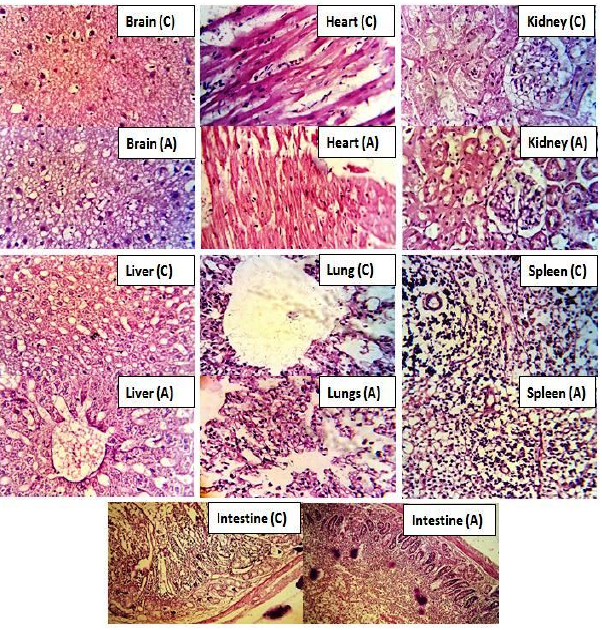
Figure 13. Histopathological images of key organs of rabbits following Na-CMC/pectin-g- (methacrylic acid) hydrogel network administration (NP-1–NP-12) in control (C) and treated (A) groups. Lungs were normal without having any sign of destruction in their